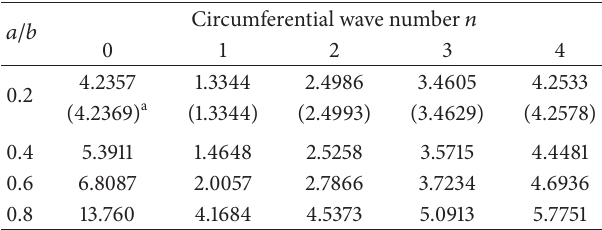
Table 9: Frequency parameters, Ω = 𝜔𝑏(𝜌(1− V 2 )/𝐸) 1/2 , for SS1-SS1 annular plates ( 𝑎/𝑏 = 0.4 ) with different cutout ratios.